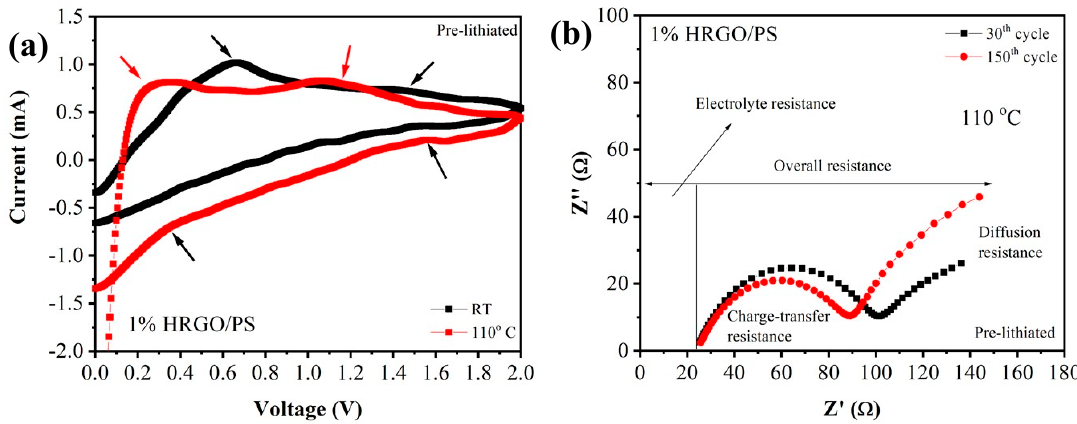
Figure 12. ( a ) Cyclic voltammetry (CV) of pre-lithiated 1% HRGO/PS electrodes and ( b ) Nyquist plot of pre-lithiated 1% HRGO/PS electrodes after the 30th and 150th cycle at 110 °C.